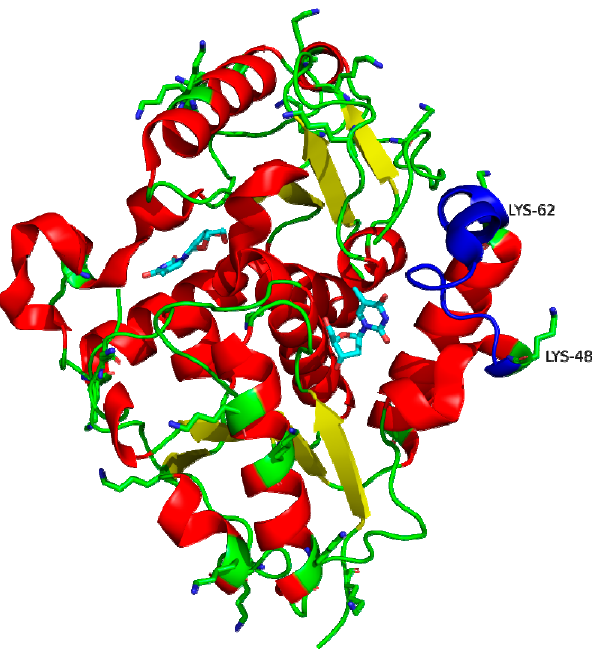
Figure 2. Overall representation of surface exposed Lys residues (atom colored sticks) in Ld NDT active site complexed with Thd (atom colored sticks). The cartoon representation is used for simplicity and ease of visualization. The catalytic loop region (amino acids 48 up to 62) is highlighted in blue. The figure has been prepared with PyMOL [34].